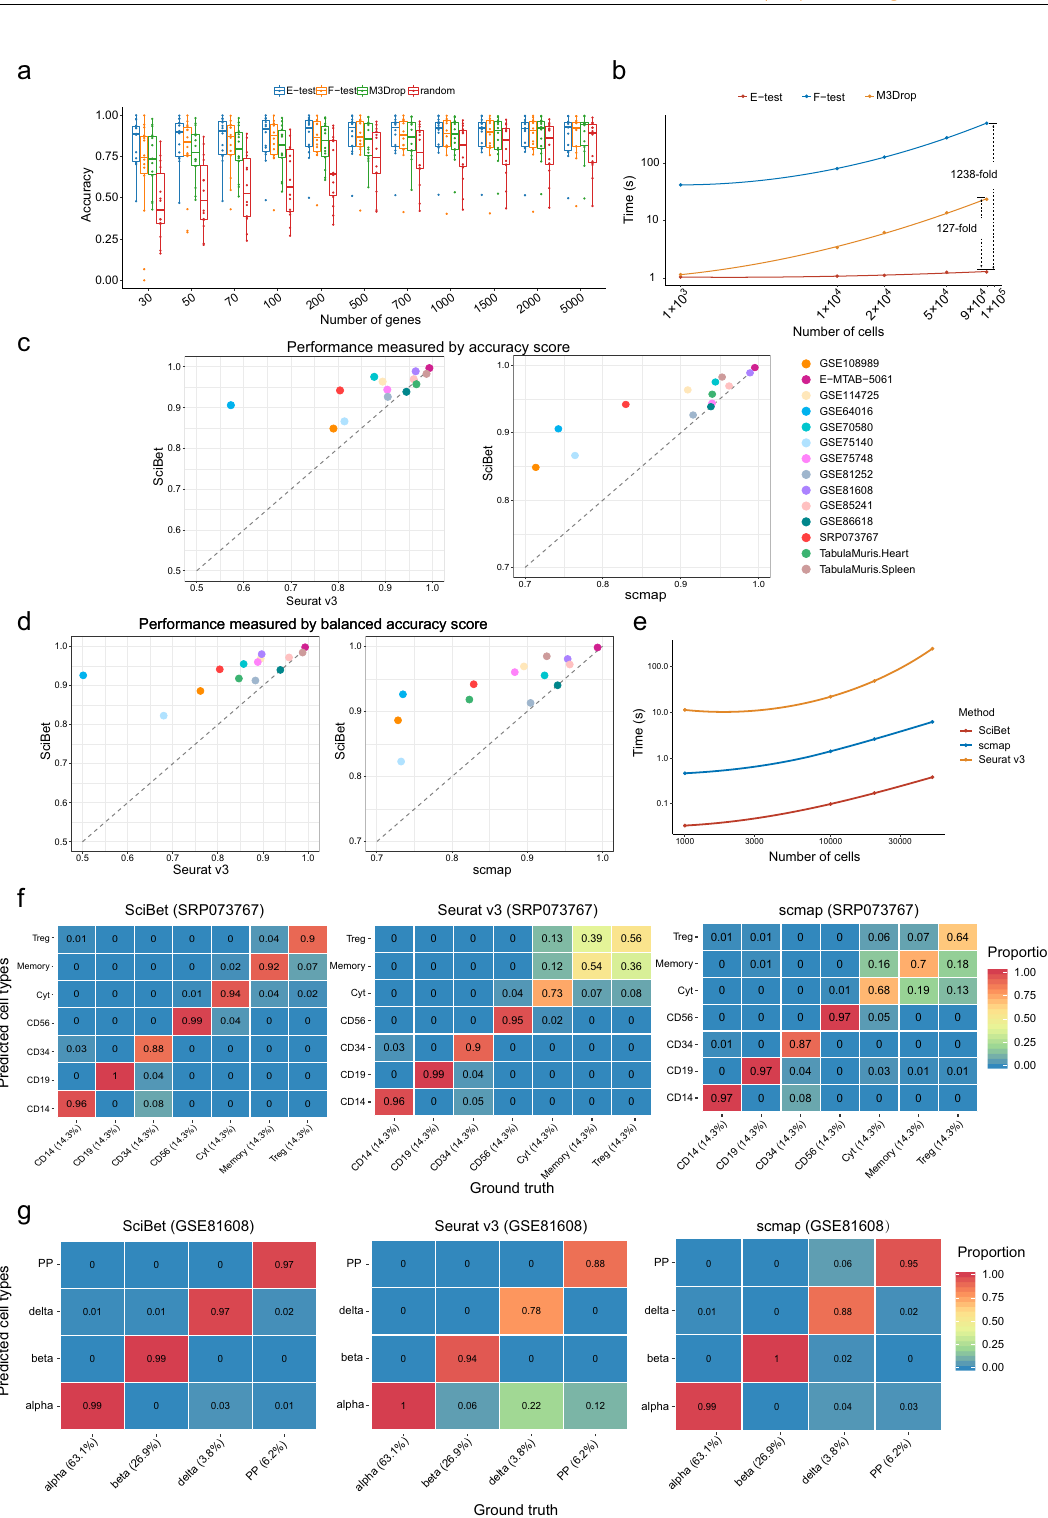
Fig. 2 Cross-validation benchmarks. a Performance of the feature selection methods measured by the accuracy score for n = 14 datasets (each dataset is plotted as an individual point, representing the mean accuracy score across 50 random repeats). Box plot shows the center line for the median, hinges for the interquartile range and whiskers for 1.5 times the interquartile range. b Single CPU consuming times for gene selection process with E-test, F-test and M3Drop (log scale). Solid lines are loess regression fi tting (span = 2), implemented with R function geom_smooth. c Performance of the classi fi ers measured by the accuracy score for n = 14 datasets (each point represents the mean score across 50 repeats). d Performance of the classi fi ers is measured by the balanced accuracy score for n = 14 datasets (each point represents the mean score across 50 repeats). e Single CPU consuming times for classi fi cation (log scale). Solid lines are loess regression fi tting (span = 2), implemented with R function geom_smooth. f Heatmap for the confusion matrix of the cross-validation result on the human PBMC dataset 10 , with normalization for each column (origin label). g Heatmap for the confusion matrix of the cross-validation result on the human pancreatic dataset 11 , with normalization for each column (origin